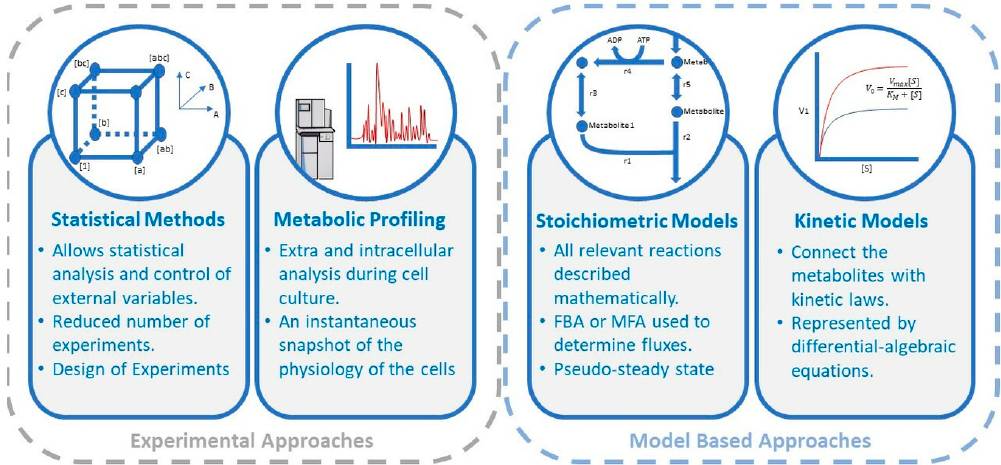
Figure 1. Overview of the mainstream approaches currently used in the optimization of amino acid composition in culture medium for recombinant protein-producing Chinese hamster ovary (CHO) cells. Note that the approaches summarized above are those specifically relevant within the domain of tailoring medium composition for optimal utilization of amino acids within the domain of recombinant protein production by CHO cells. A plethora of alternative systematic strategies not limited to those covered here (beyond the scope of this Review) exist, which deal with different aspects of improving biomanufacturing platforms for CHO cell-based technologies. FBA: flux balance